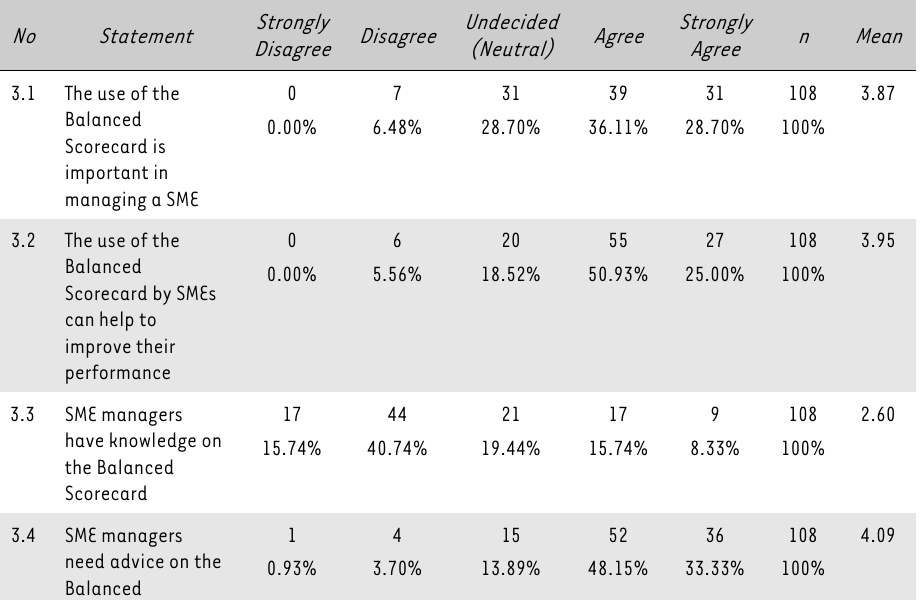
Summary of responses on the Balanced Scorecard